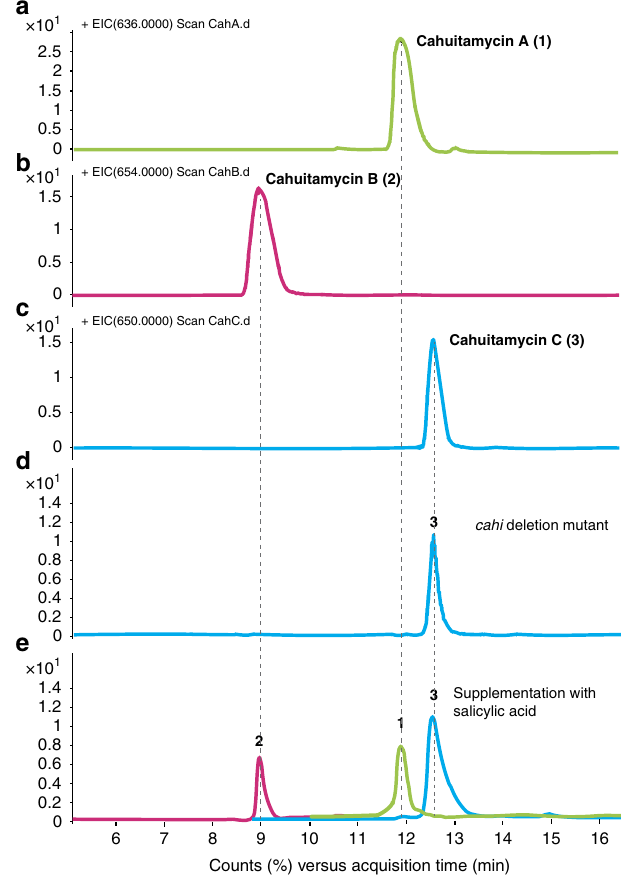
Figure 3 | Chemical complementation of the cahI deletion mutant of S. gandocaensis . LC-ESI-MS chromatograms of 1 – 3 obtained from culture of DHS287 ( a – c ) the cahI deletion mutant DHS334 ( d ) supplemented with 100 m M of salicylic acid ( e